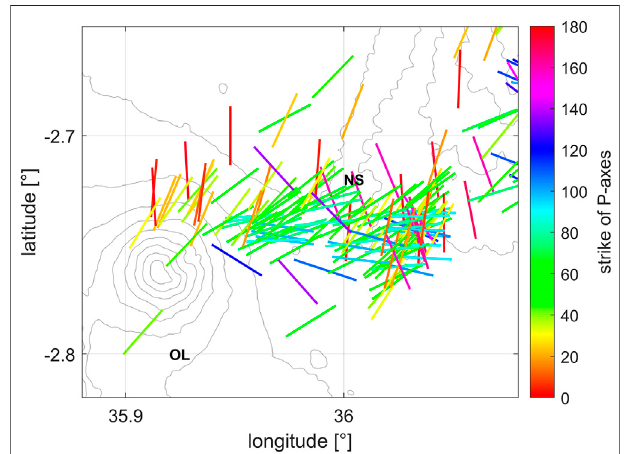
FIGURE 11 | Map view of P-axis directions of focal mechanisms below Oldoinyo Lengai and Naibor Soito. Axes are centered on their earthquake location and colored by their